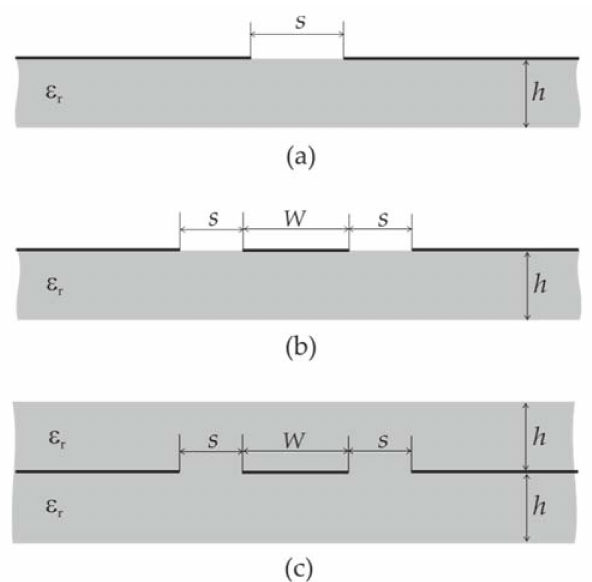
Figure 2. Cross sectional view of the slot structure ( a ), equivalent coplanar waveguide (CPW) structure ( b ) and symmetric CPW structure, with the metal layer equally covered at both sides ( c ). The vertical symmetry planes in the CPWs of ( b , c ) are perfect magnetic walls for the fundamental (even) CPW mode. The horizontal symmetry plane in ( c ) is a perfect magnetic wall, whereas the horizontal plane in ( a , b ) are quasi-magnetic walls, provided E rel is